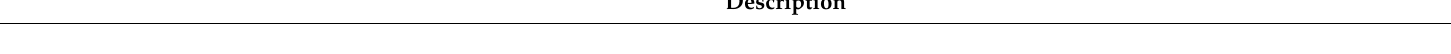
Table 2. Explanatory variables used to determine drivers of the selection of farms by Canarian Egyptian Vultures.